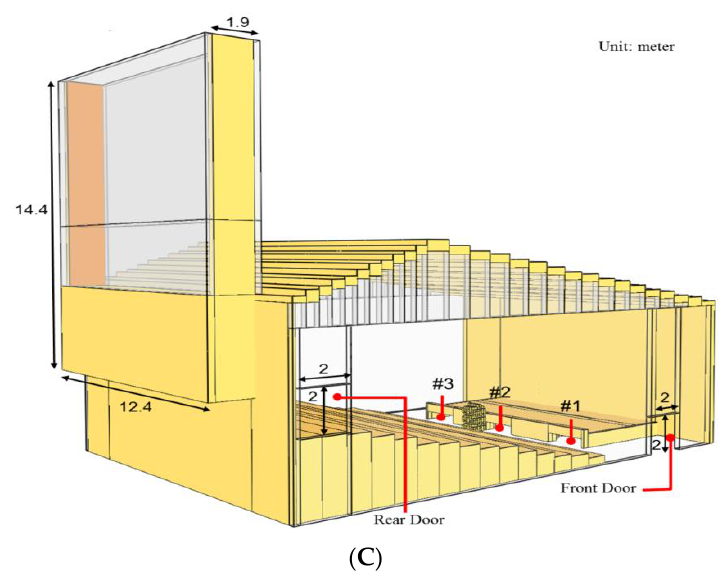
Figure 6. Building appearance: ( A ) front isometric view; ( B ) side view; and ( C ) rear isometric view.